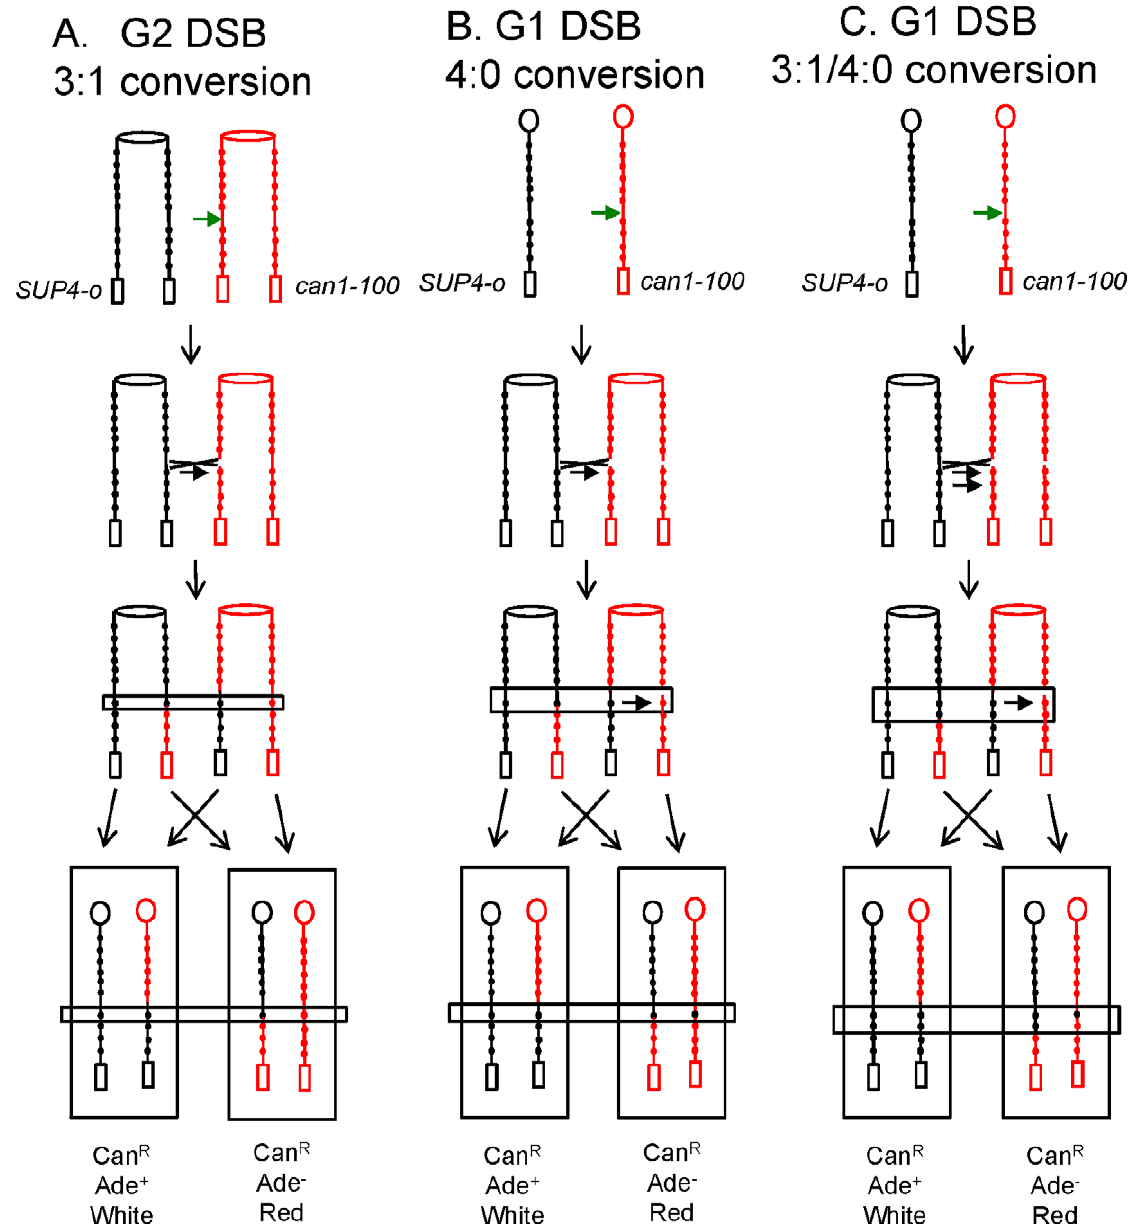
Figure 2. Gene conversion events associated with crossovers in G2 and G1. The depictions of chromosomes, centromeres, and polymorphic markers are the same as in Figure 1. The regions involved in the conversion event are enclosed within horizontal rectangles. A. 3:1 conversion associated with an RCO initiated by a double-strand DNA break (DSB) in G2. Following a DSB on the can1-100 -containing chromosome, a conversion event in which information is transferred from the SUP4-o- containing chromosome occurs; this conversion event is associated with the RCO. For 3:1 conversion events, one sector is homozygous for the polymorphic marker and the other sector retains heterozygosity. B. 4:0 conversion associated with a DSB in G1. One of the unreplicated chromosomes is the target of a DSB, and the broken chromosome is replicated to yield two broken chromatids. The repair of the first chromatid is associated with an RCO and a conversion event. The repair of the second chromatid is unassociated with an RCO but underwent conversion of the same marker. In the resulting colony, both sectors are homozygous for the same polymorphic marker. C. 3:1/4:0 hybrid conversion associated with a DSB in G1. As in Figure 2B, the recombination-initiating lesion occurs in unreplicated chromosomes. In this event, however, repair of the first DSB converts two markers, whereas repair of the second converts only one marker. The net result is a 3:1/4:0 hybrid tract. doi:10.1371/journal.pgen.1001270.g002 The rates of RCOs with 95% confidence limits, based on an These diploid strains were constructed from two haploid parents (PSL2 and PSL5) with numerous sequence polymorphisms allowing average of the number of sectored colonies in at least 20 cultures, mapping of the positions of the crossovers as described further are shown in Table 1. Strains homozygous for (GAA) 20 or (TTC) 20 below. tracts (WXTMD42 and WXTMD40) had rates of RCOs of about